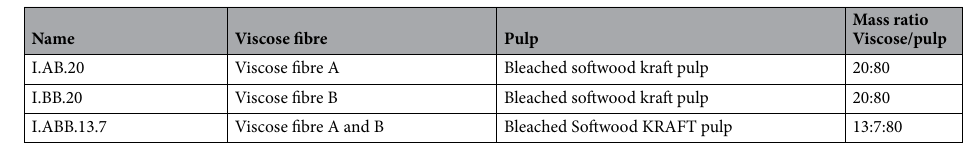
Table 3. List of nonwovens from industrial pilot production. IW stands for industrial web, VA/VB for viscose type and BSK for bleached softwood kraft pulp.